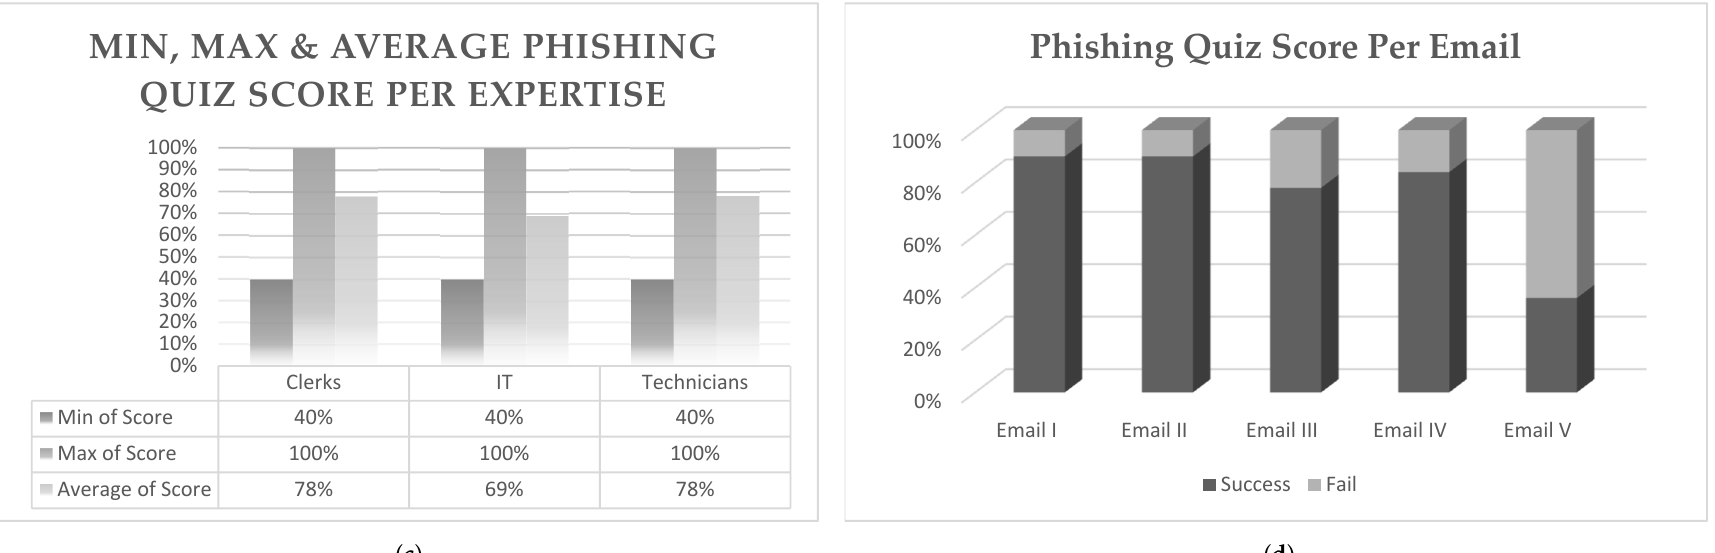
Figure 5. Campaign generic assessment results: ( a ) overall, ( b ) per group, ( c ) per expertise and ( d ) per